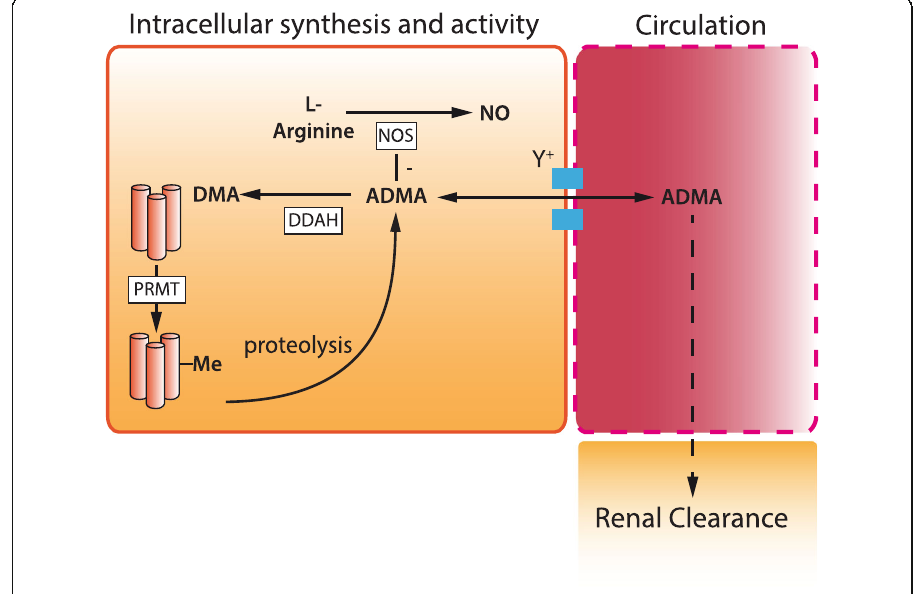
Fig. 2 Methylarginine-mediated nitric oxide synthase inhibition. Representative image of the synthesis and regulation of ADMA. Protein Arginine Methyl Transferases (PRMT) catalyse the methylation of arginine containing protein residues to ADMA and SDMA which are released upon proteolysis. ADMA and SDMA are transported via the y + cationic amino acid transporter into and out of the circulation. ADMA is metabolised by the two isoforms of dimethylarginine dimethylaminohydrolase (DDAH) in a wide range of tissues. ADMA acts intracellularly to inhibit nitric oxide synthase (NOS). ADMA is largely metabolised by DDAH to dimethylamine (DMA), a small amount is cleared unchanged through the kidney. nb. L-NMMA (monomethylarginine) is considered to have the same synthetic pathway, activity, metabolism and clearance as ADMA but is present in only 10% of the